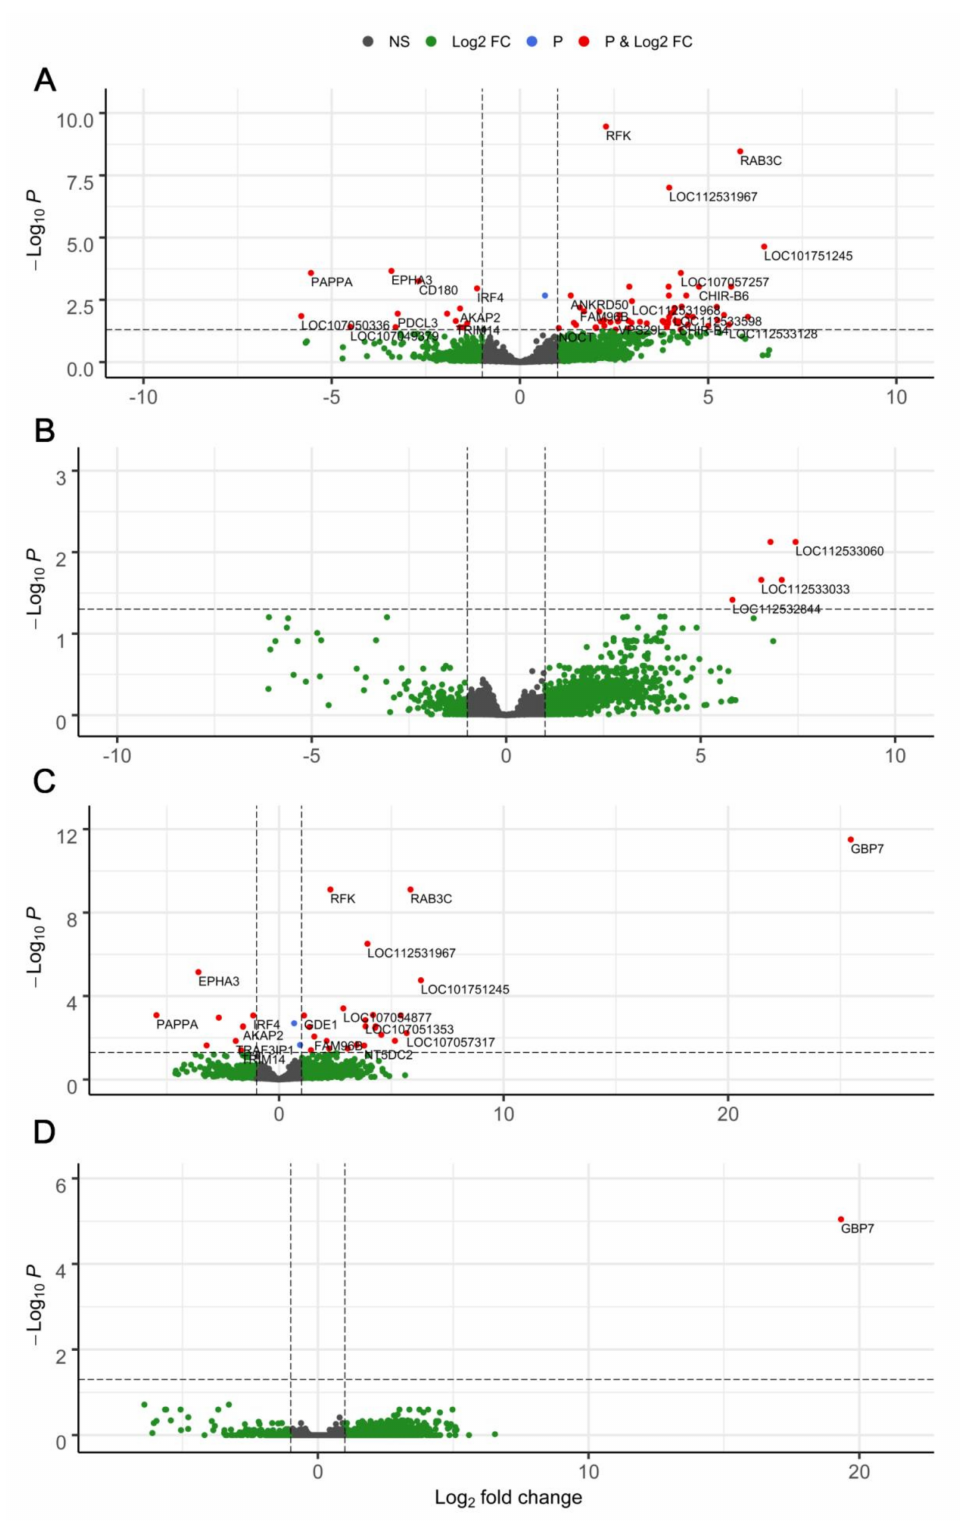
Figure 3. Volcano plots illustrating significantly differentially expressed genes (red dots) influenced by ( A ) host genetic background (Lohmann Dual vs. Lohmann Brown Plus); ( B ) nematode infection intensity level (lower vs. higher); ( C ) the effect of host genetic background adjusted for infection intensity level; and ( D ) the effect of infection intensity adjusted for genotype effects. Abbreviations: NS: not significantly different; Log2FC: significantly different according to Log2FC; P: significantly different according to p -value; P and Log2FC: significantly different according to p-value and